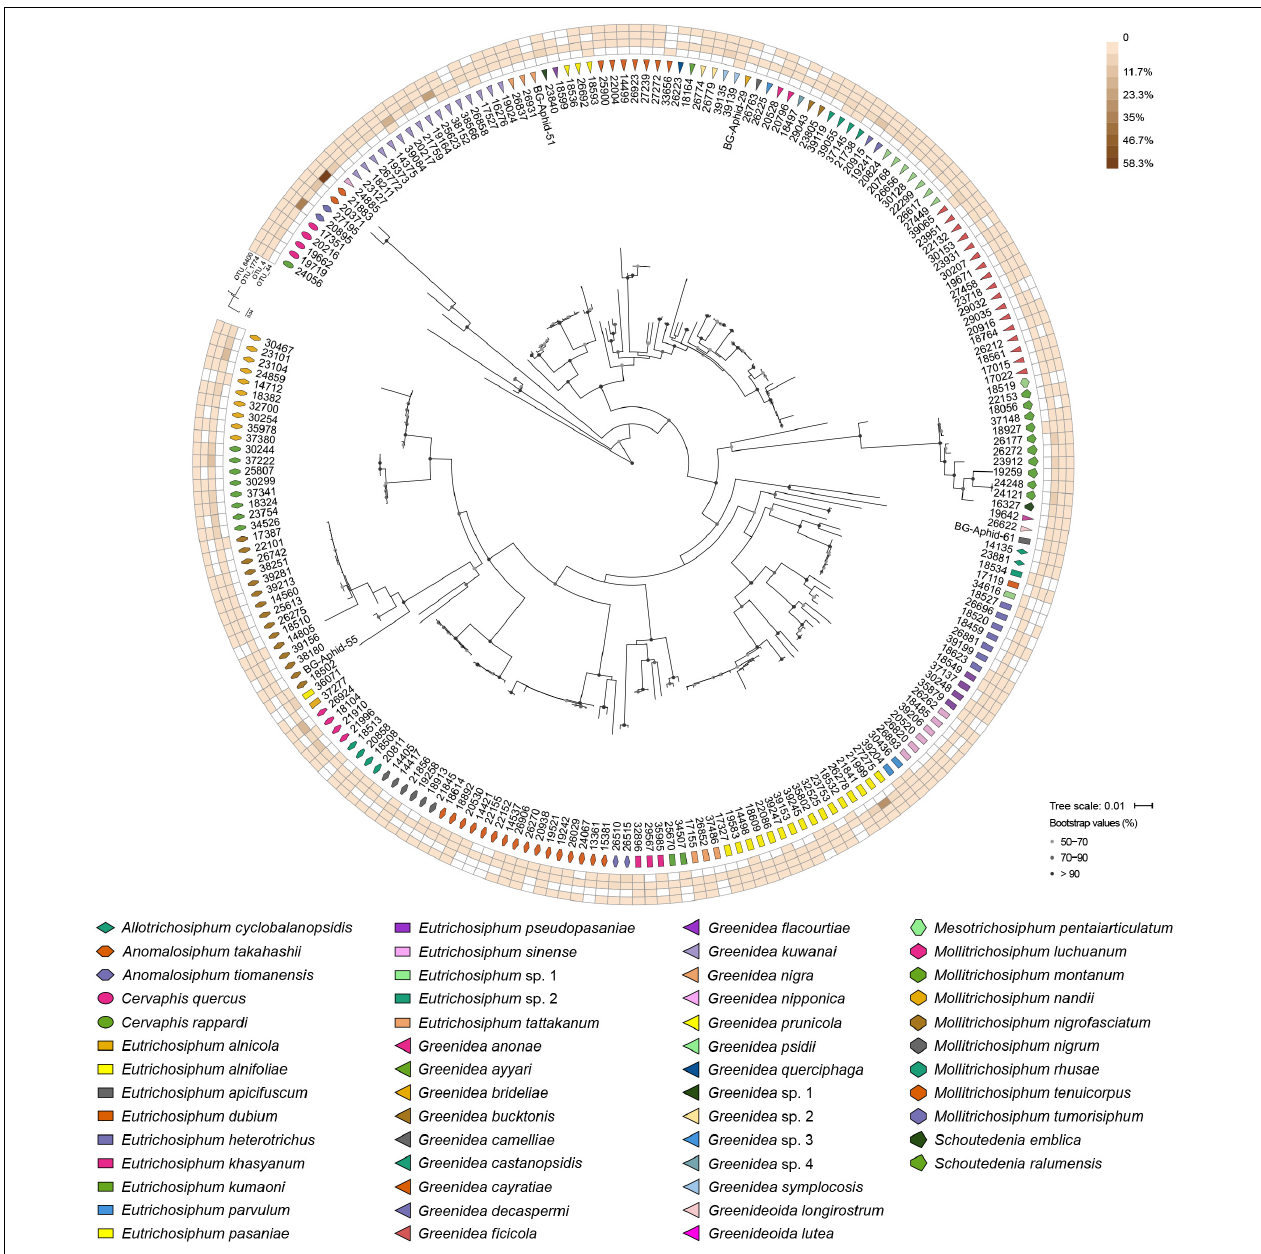
FIGURE 3 | Heatmap representing the distribution and relative abundances of Wolbachia OTUs among Greenideinae aphids. The maximum-likelihood trees display the phylogenetic relationships of Greenideinae and Wolbachia OTUs.